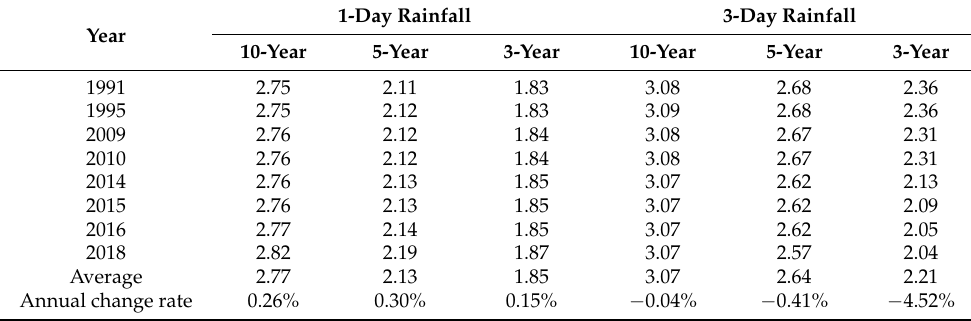
Table 5. Drainage duration corresponding to the empirical formula under 1-day and 3-day rainfall with different return periods ( T E , in